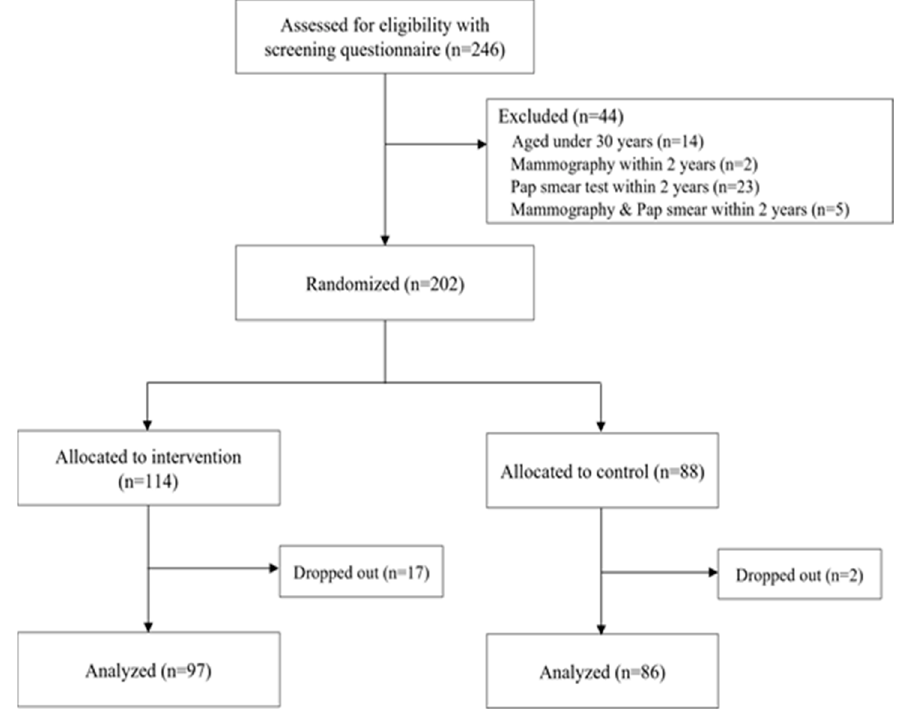
Figure 1. Flowchart of participant selection.